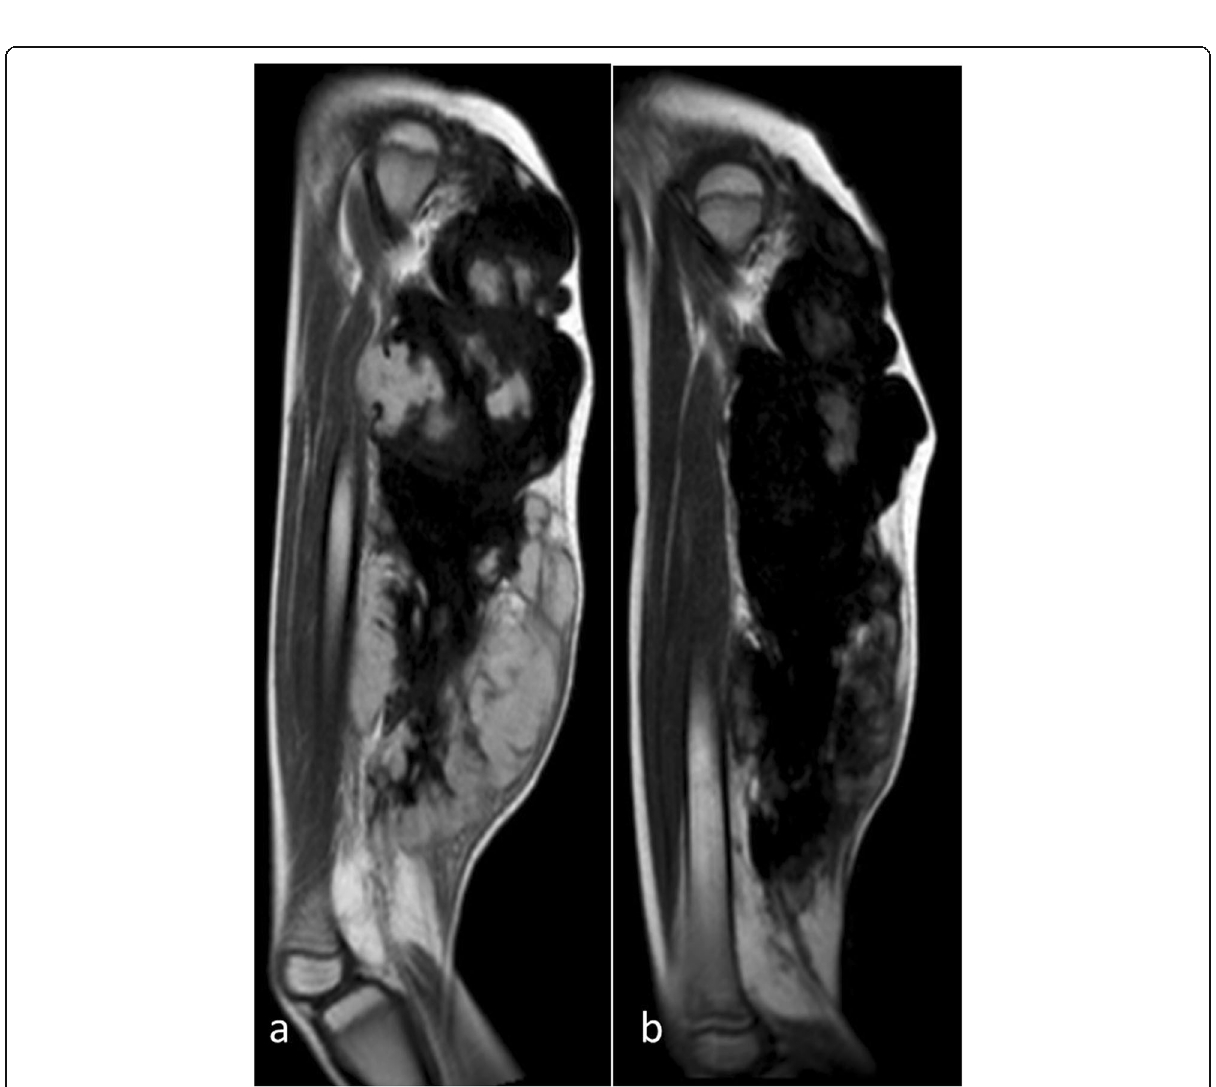
Fig. 3 Right thigh fibromatosis in a 9-year-old male; sagittal T1 post-contrast images a pre-therapy and b post-therapy showed progressive growth of the low signal fibrous areas within the lesion and reduction of the cellular enhancing areas denoting favorable response to therapy